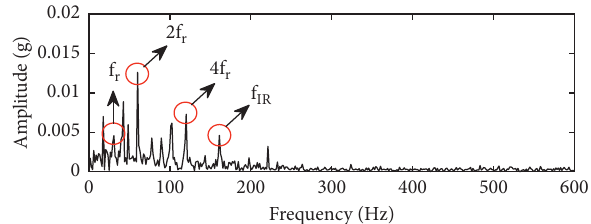
Figure 15: Vector LCD spectra of x-signal under inner race fault